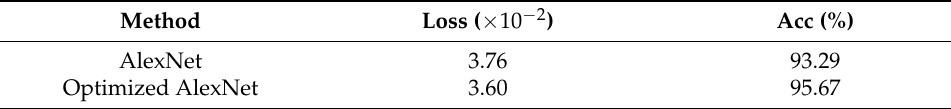
Table 2. Loss and accuracy of AlexNet and optimized